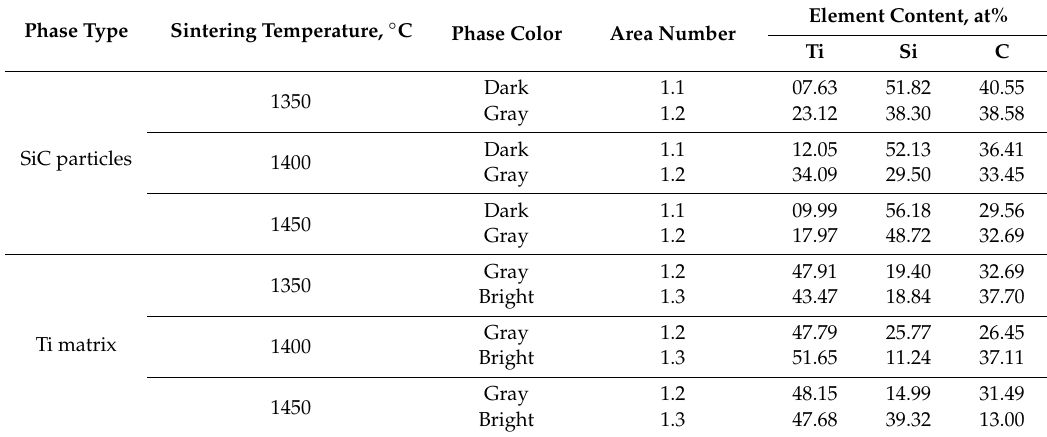
Table 2. SEM-EDS analysis results of composites SPSed at 1350, 1400 and 1450 ◦